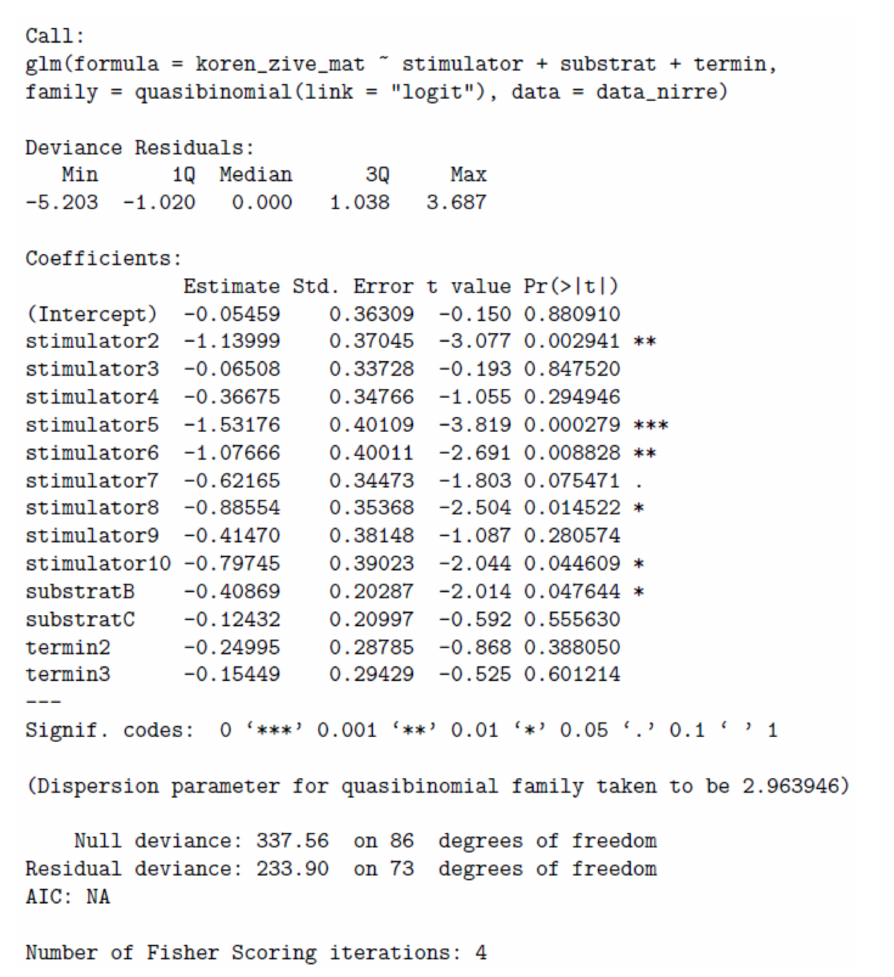
Figure A5. Parametrization of the quasi-binomial model predicting the proportion of rooted cuttings from surviving cuttings, including Wald tests of the significance of differences between the reference (Stimulator 1, Substrate A, Date 1) and remaining levels of each factor.